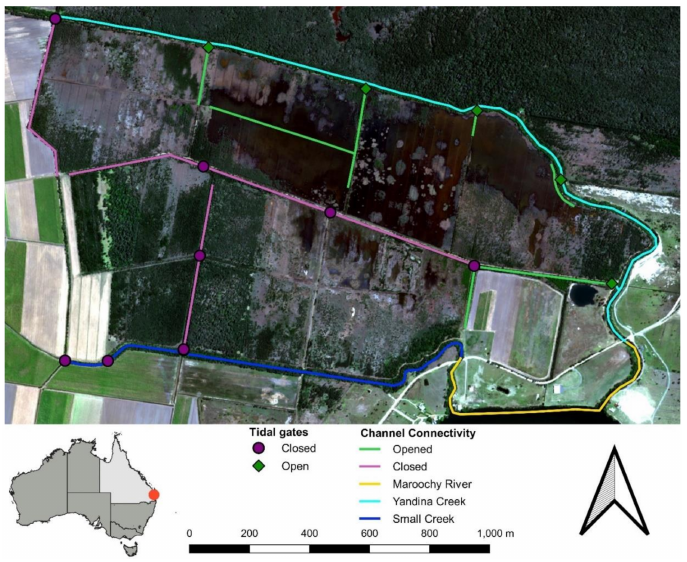
Figure 1. The Yandina Creek wetlands, and the distribution of tidal gates, drainage channels and natural waterways on the